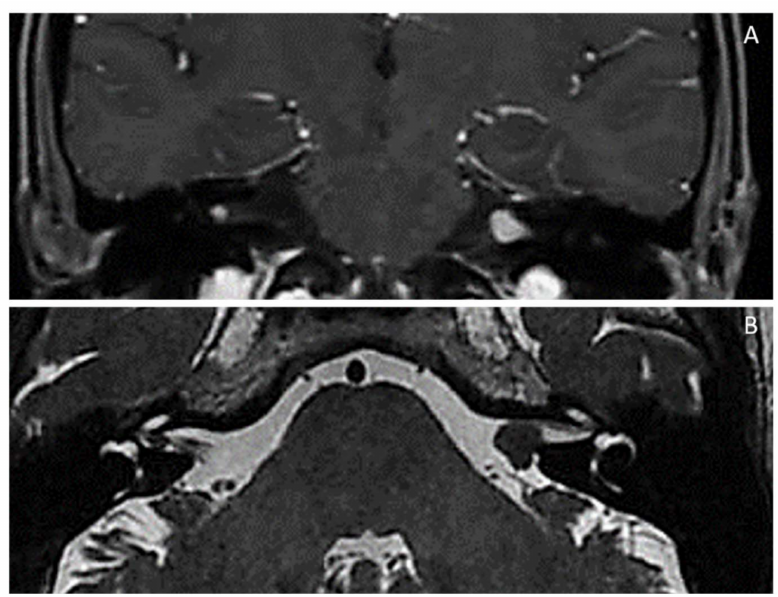
Figure 12. Patient with NF2-related schwannomatosis (ex-NF2): ( A , B ) bilateral acoustic schwannoma is pathognomonic. Table 8. Key diagnostic features of classic-type